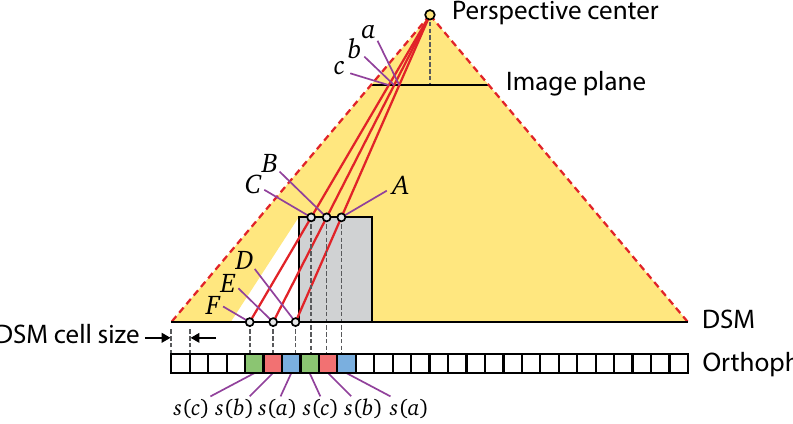
Figure 1. Problem of double-mapped areas within the differential rectification method. DSM: digital surface model.